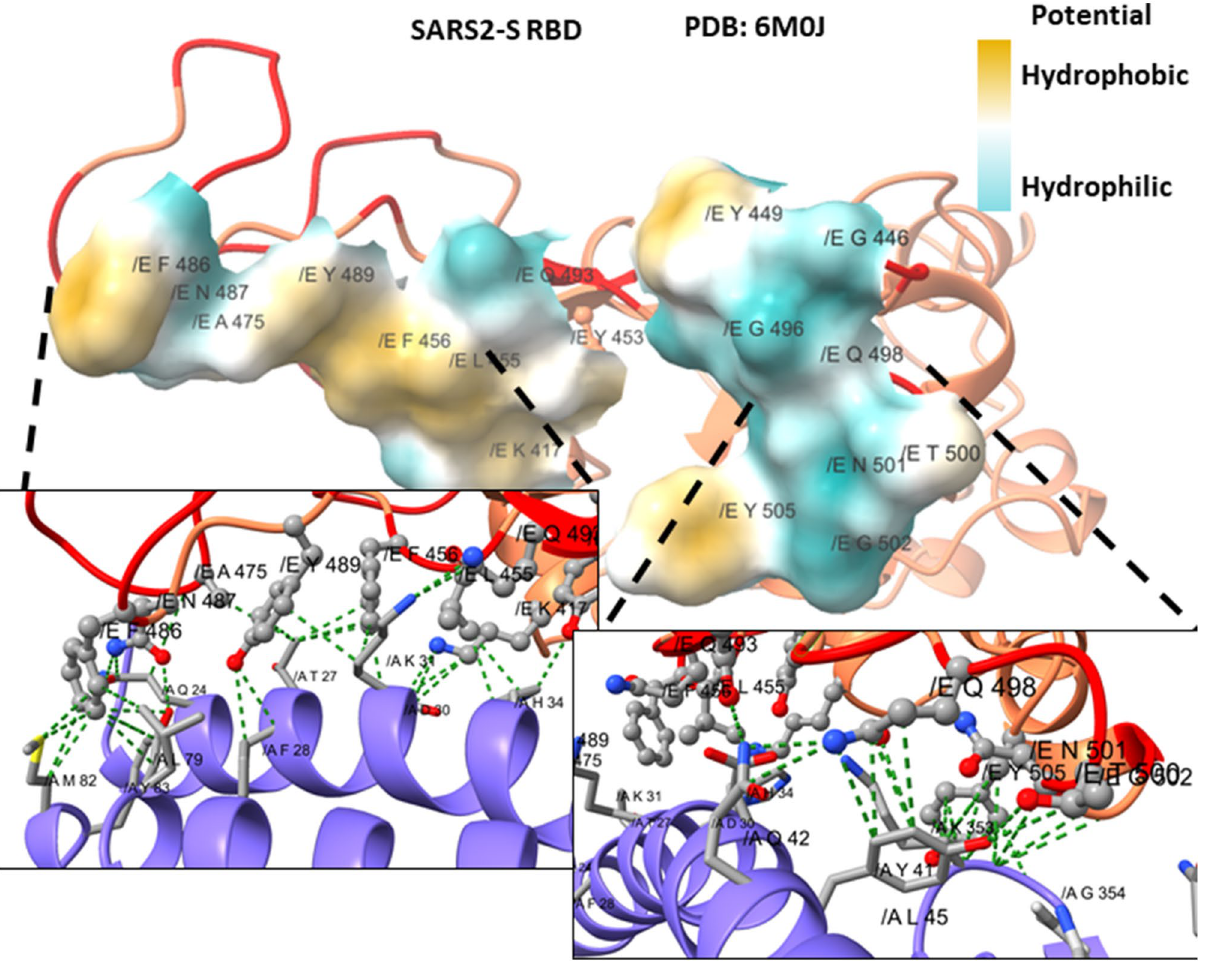
Figure 3. Unique residues of SARS2-S contact more the receptor ACE2. The surface of the amino acids involved in protein–protein interaction with the receptor is colored by its hydrophobic potential. Specific pockets are zoom in to show the responsible residues. Compared to other ACE2 binding spikes, SARS2-S has Phe 456 and Phe 486 in the interface which enables more hydrophobic area (left down) and Gln 498 enables